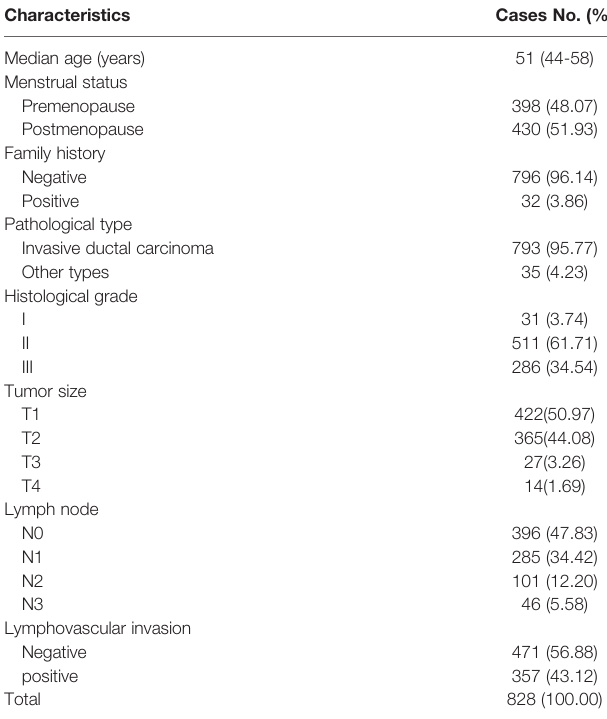
TABLE 1 | Clinical characteristics of breast cancer